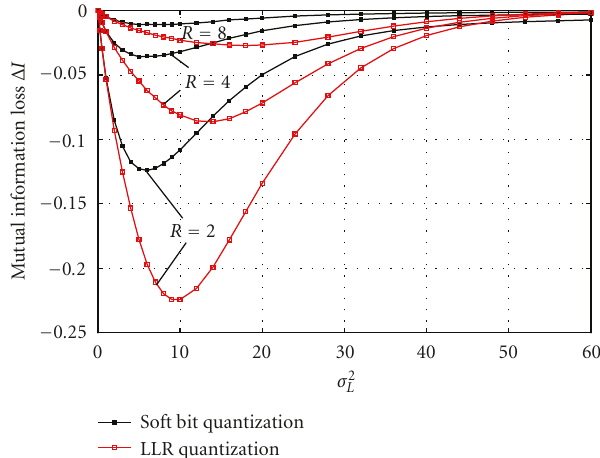
Figure 18: Mutual information loss Δ I ( X ; L ) for 1–3 quantization bits as a function of the variance of the L